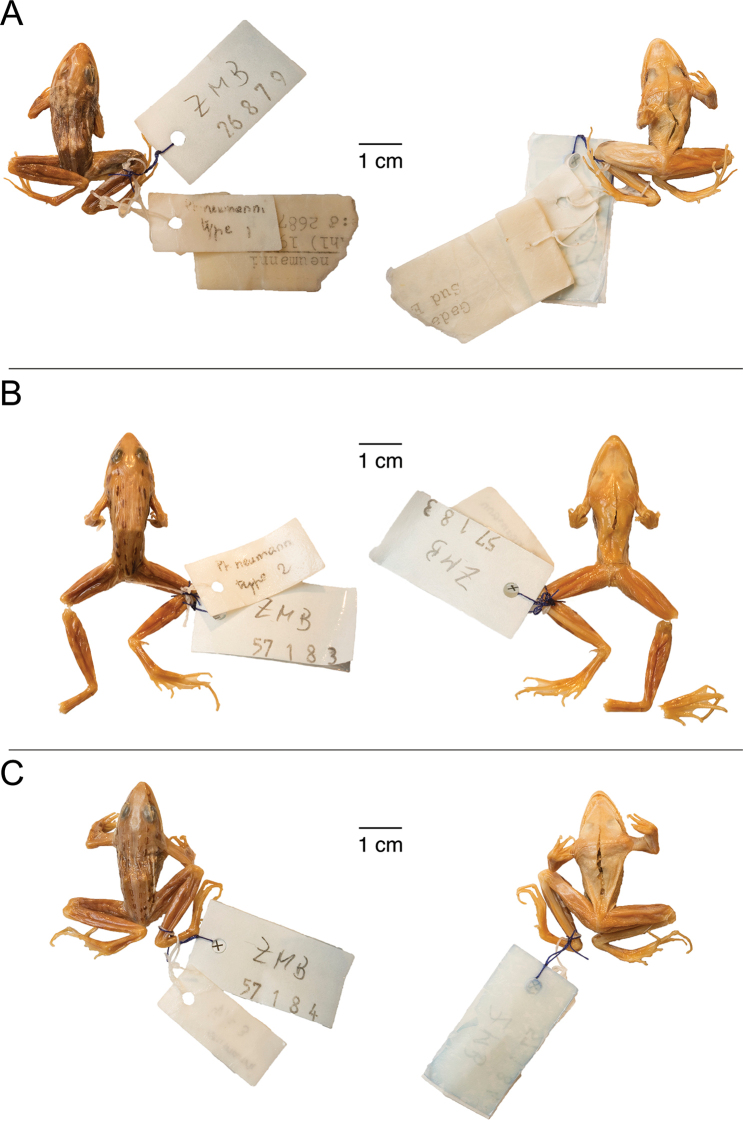
Type specimens of Ptychadena
neumanni. Dorsal and ventral views of three male type specimens A ZMB26879–1, lectotype BZMB–57183 = ZMB26879–2, paralectotype CZMB–57184 = ZMB26879–3, paralectotype.